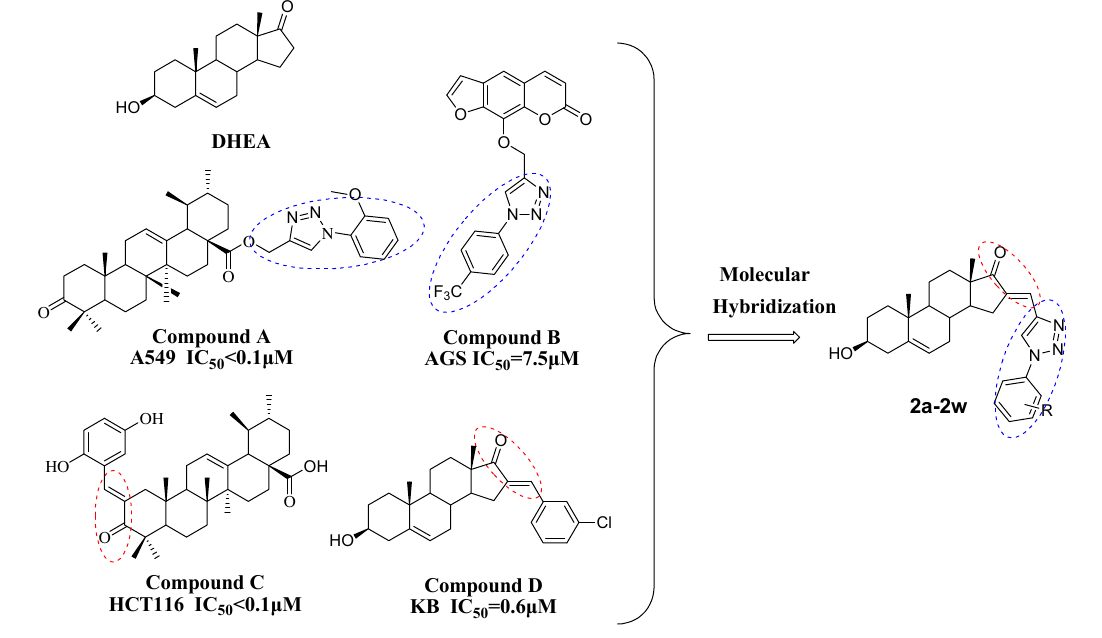
Figure. 1. Design of target compound 2a – 2w . Figure 1. Design of target compound 2a – 2w